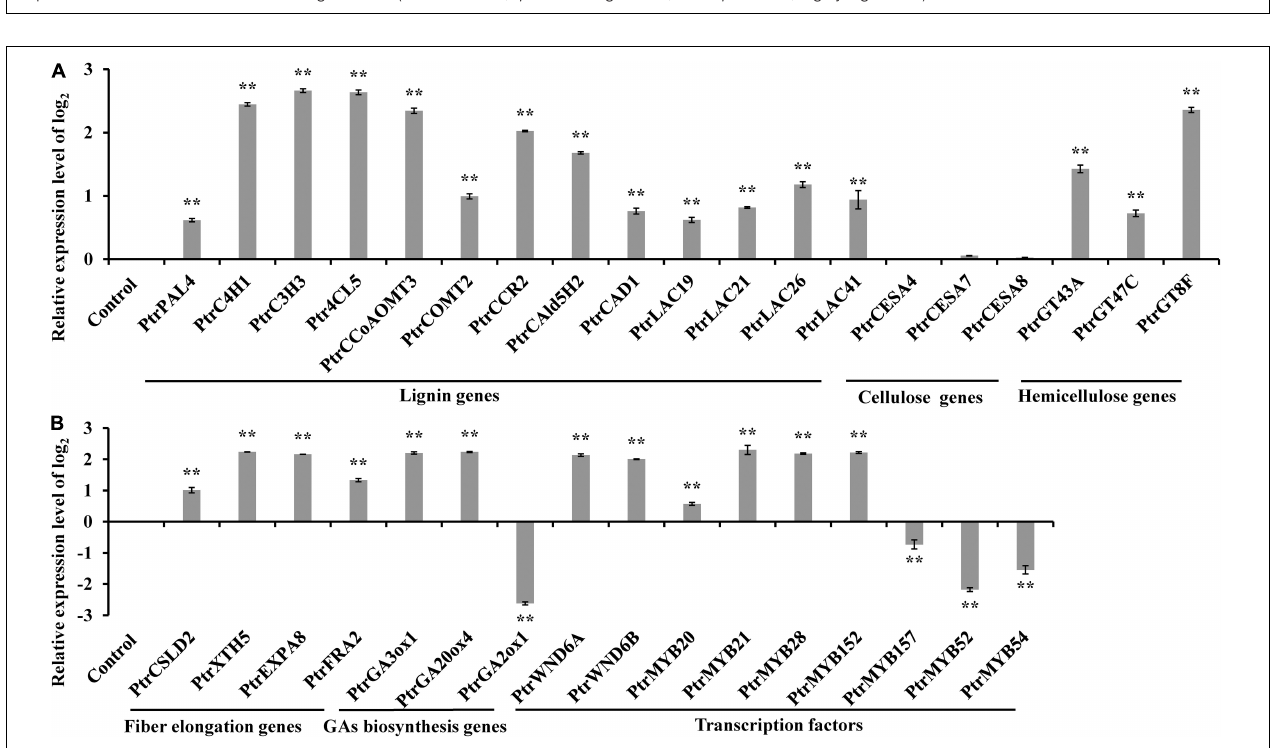
FIGURE 5 | Effect of PtrWOX13A overexpression on secondary cell wall of stems in Populus trichocarpa . (A–E) Represent lignin content, cellulose content, hemicellulose content, fiber length, fiber diameter, GA 1 content, and GA 4 content, respectively. Error bars represent the standard deviation of three biological replicates. Asterisks indicate levels of significance (Dunnett’s test; * p < 0.05 significant, and ** p < 0.01, highly significant).